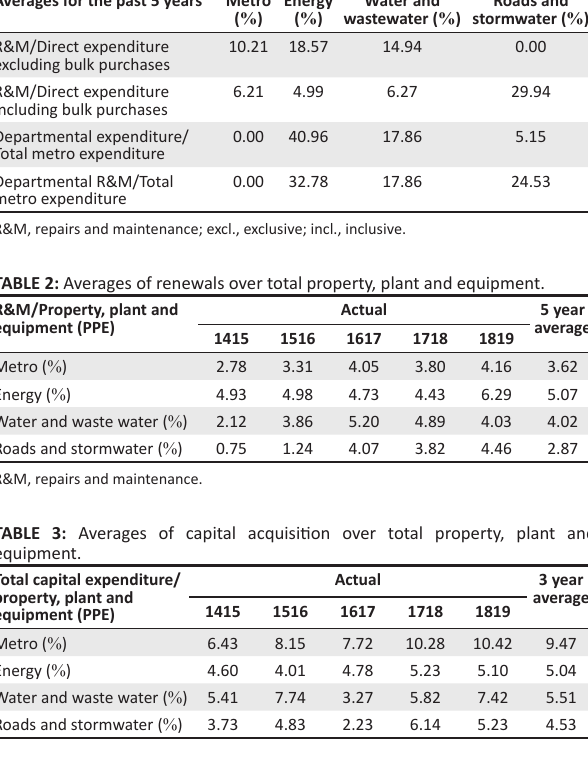
TABLE 1: Financial analysis and interpretation – Averages of repairs and maintenance over direct expenditure. Averages for the past 5 years Metro